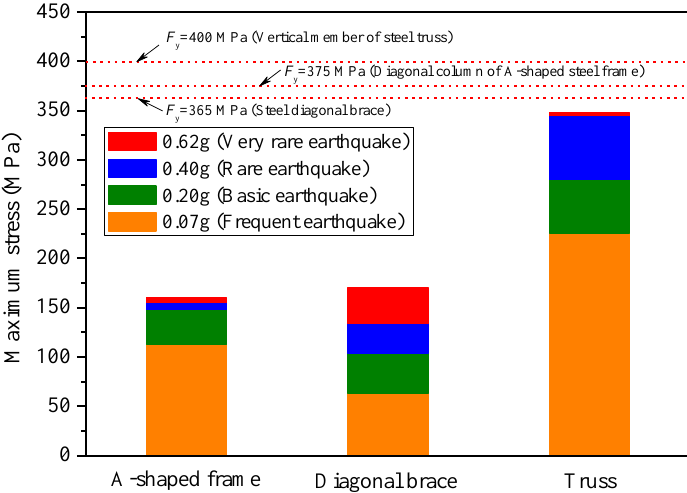
Figure 18. Maximum stress of the steel components of structure subjected to different hazard levels.